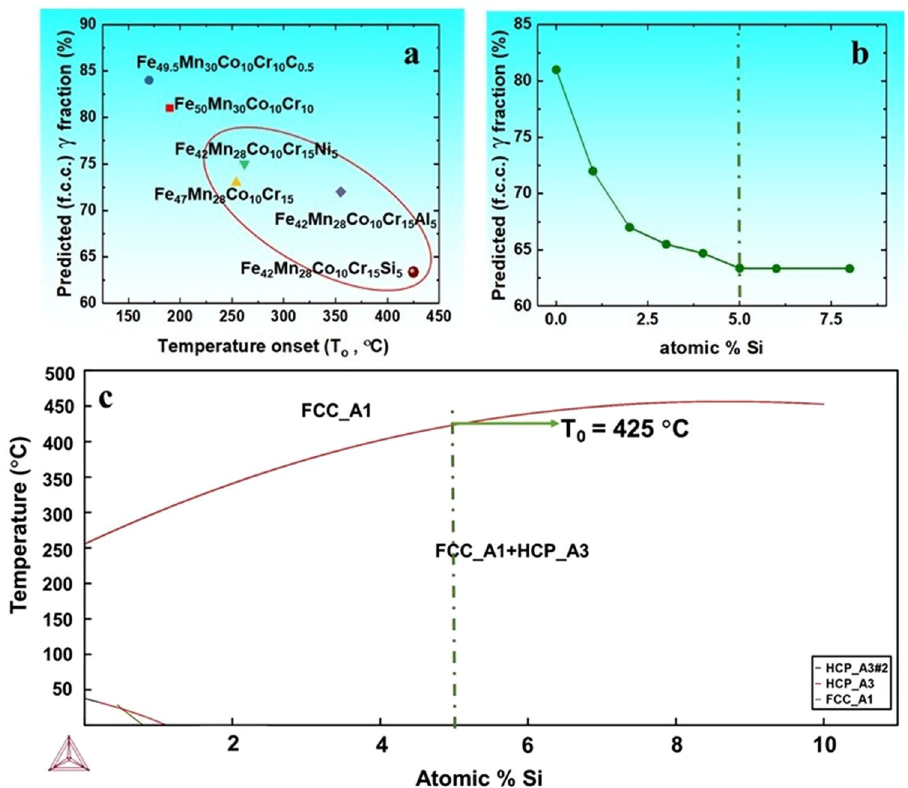
or Ni and x: at.% contribution of selected alloying element) system in comparison with Fe 50 Mn 30 Co 10 Cr 10 and Fe 49.5 Mn 30 Co 10 Cr 10 C 0.5 alloys; ( b ) Effect of Si content on equilibrium γ phase fraction using Thermo-Calc and; ( c )